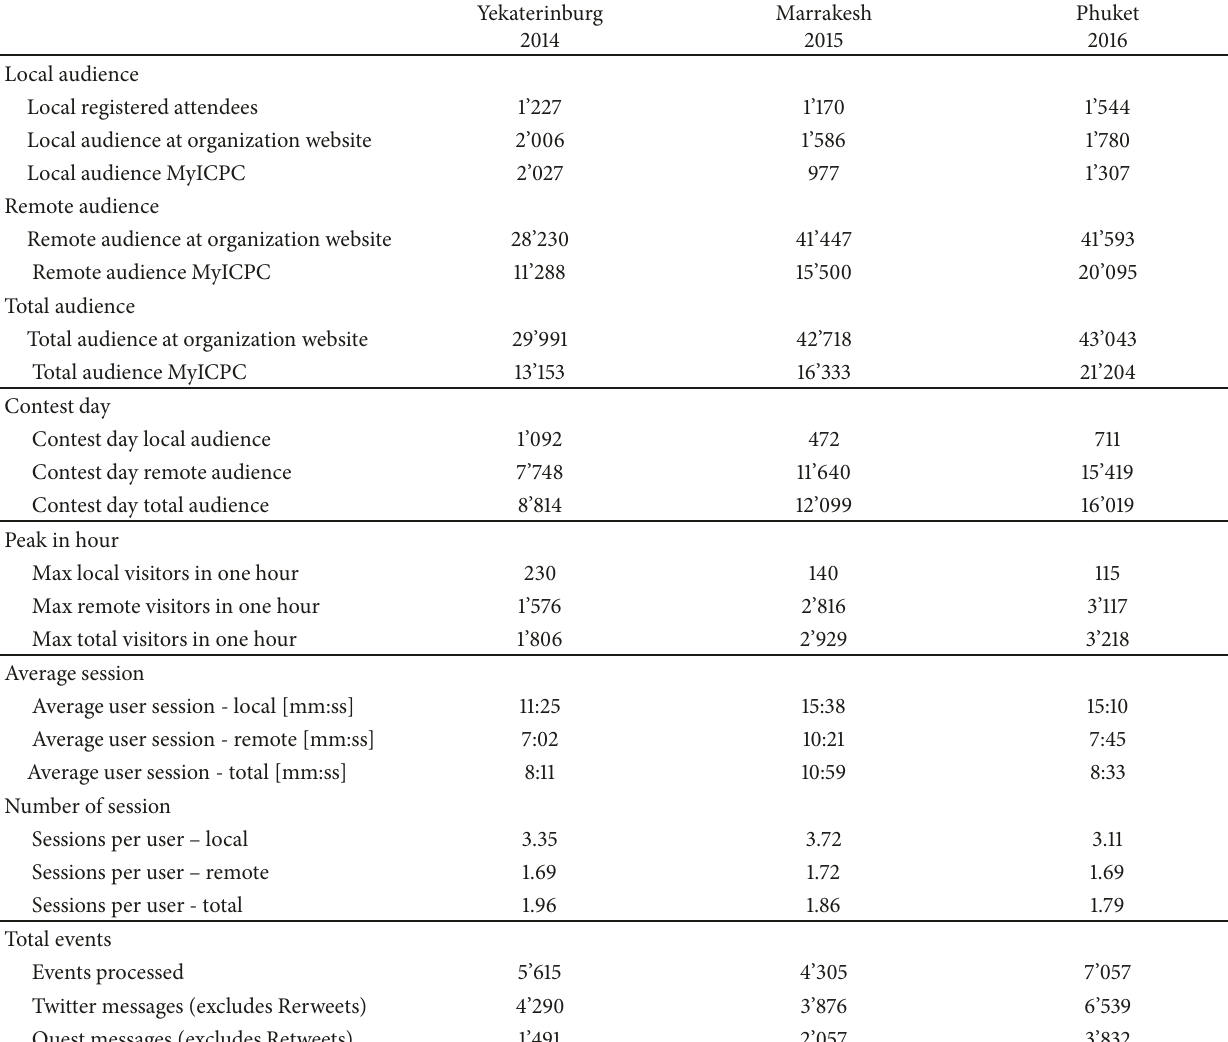
Table 1: World Finals 2014-16 statistics.